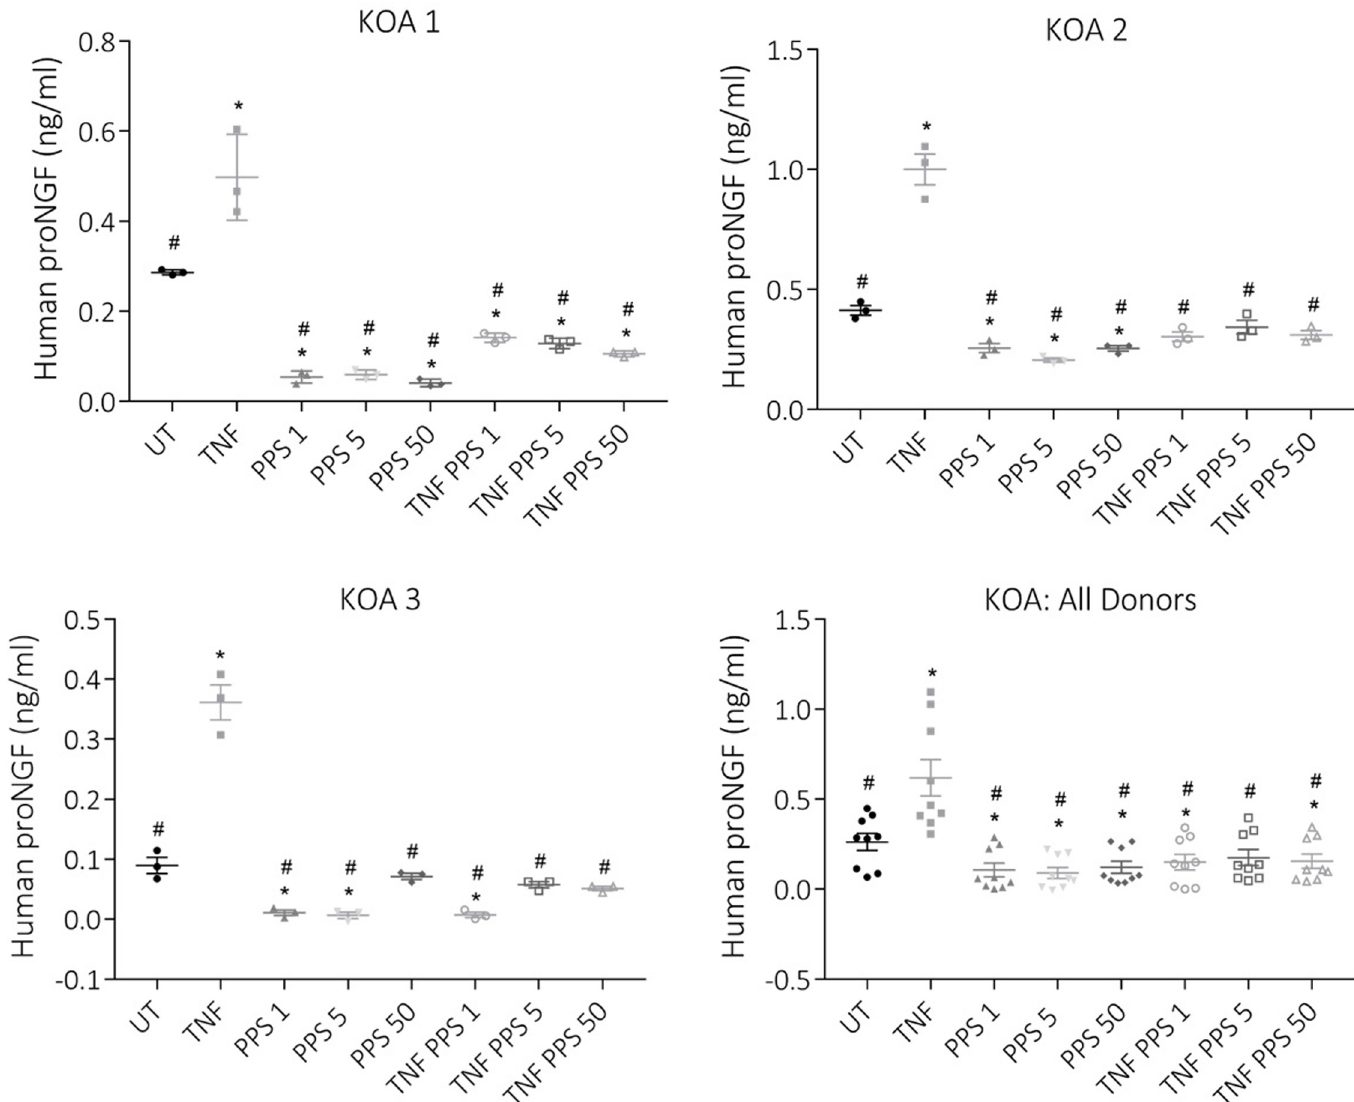
Fig 4. Human osteocyte-like cells secrete proNGF. Secretion of proNGF was tested from cultures of KOA osteocyte-like cells treated with combinations of rhTNF and PPS. Data are means + SD of supernatants harvested from triplicate wells. Significant difference to untreated control (UT) is indicated by � ( p < 0.05); significant difference to rhTNF treated cultures is indicated by #( p <